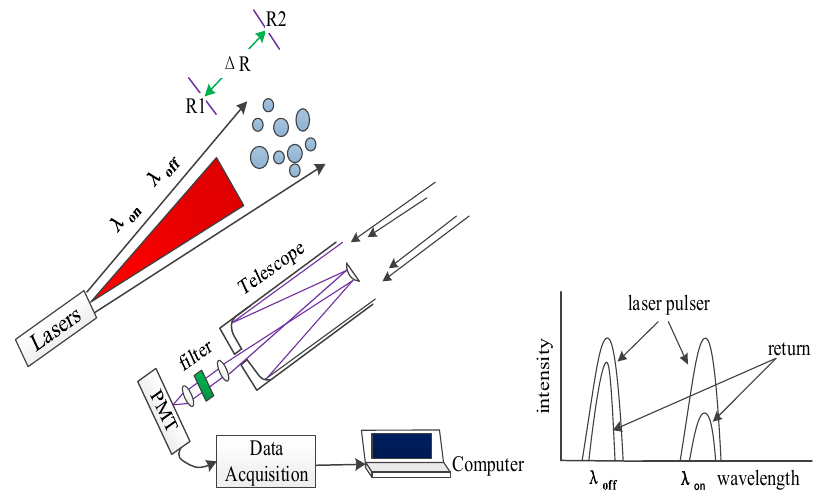
Figure 1. Diagram of ground-based CO 2 -DIAL system.